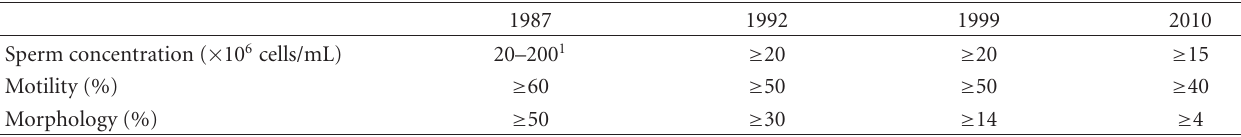
Table 2: Changes in the three main semen parameters through time (1987–2010). A semen parameter was considered normal when the values were equal or above the presented figures